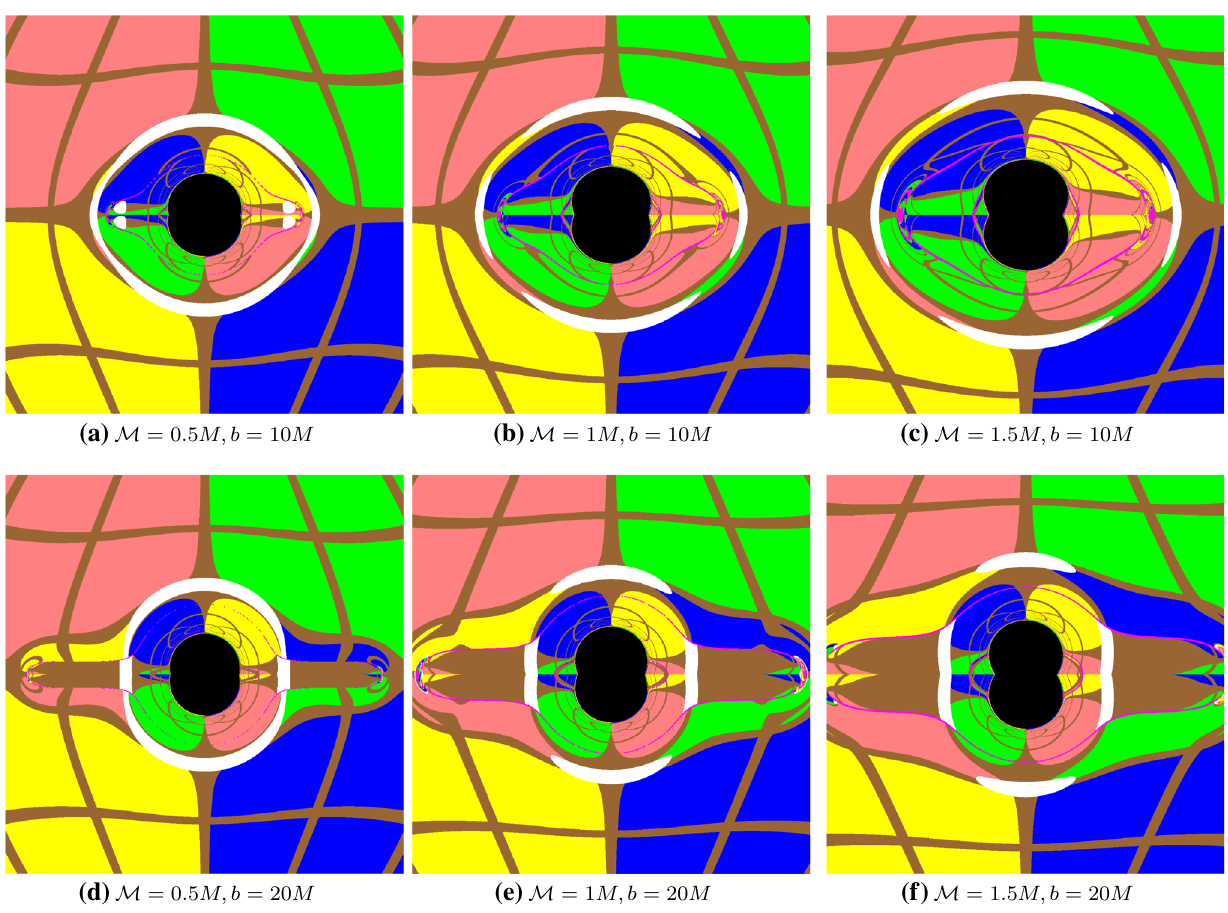
Fig. 1 The dependence of black hole shadow on the ring mass M for fixed Weyl radius b . The upper row is for b = 10 M and The bottle one is for b = 20 M . Here we set the black hole M = 1 and the observer locates in the position with r obs = 50 M and θ obs = π/ 2